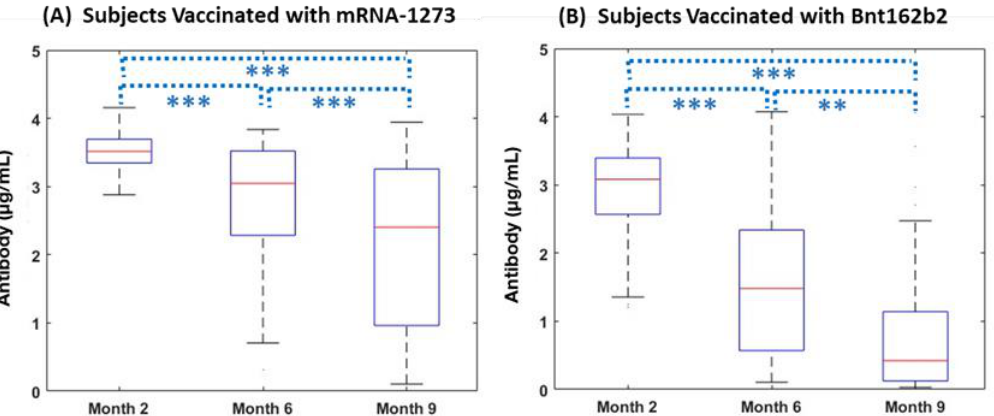
Figure 3. Changes in Antibody over Time by vaccine manufacturer for subjects without pre-vac-